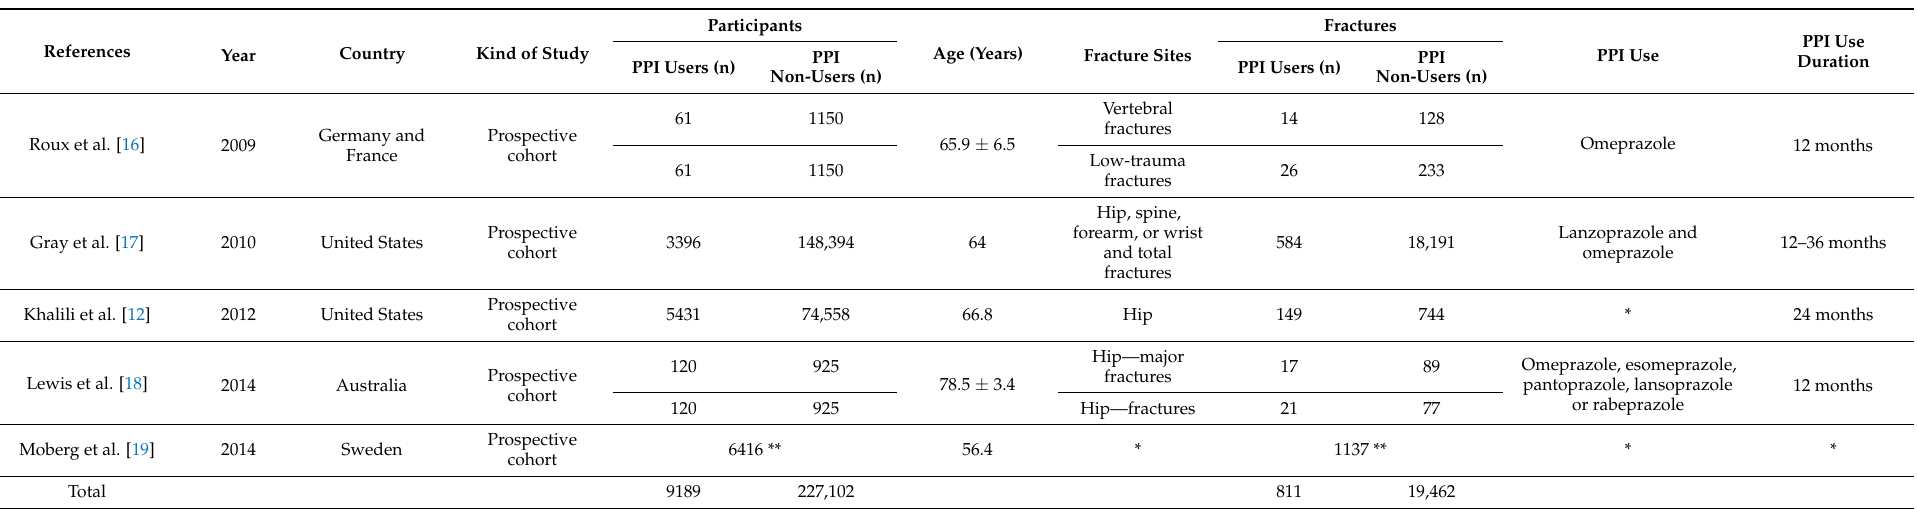
Table 1. Data from selected studies relating the fractures and the use of